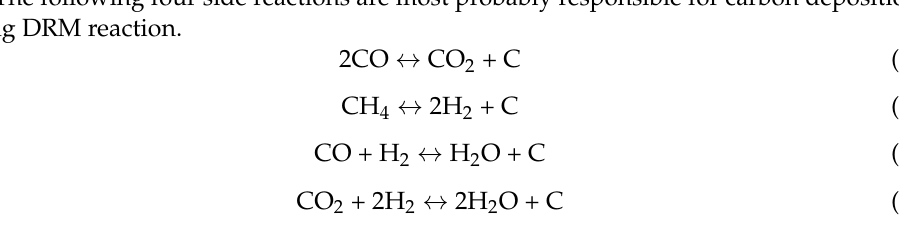
Figure 4. TPO profiles for Ni supported on alumina (NA), Ni supported on Y-zeolite (NY), and Ni supported on H-ZSM-5 (NH) spent catalysts.